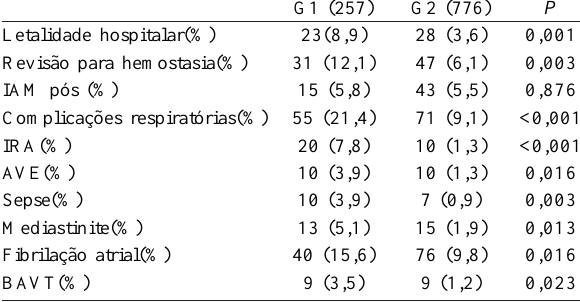
Tabela 1. Características demográficas e clínicas pré-operatórios distribuídas por ambos os grupos de pacientes.